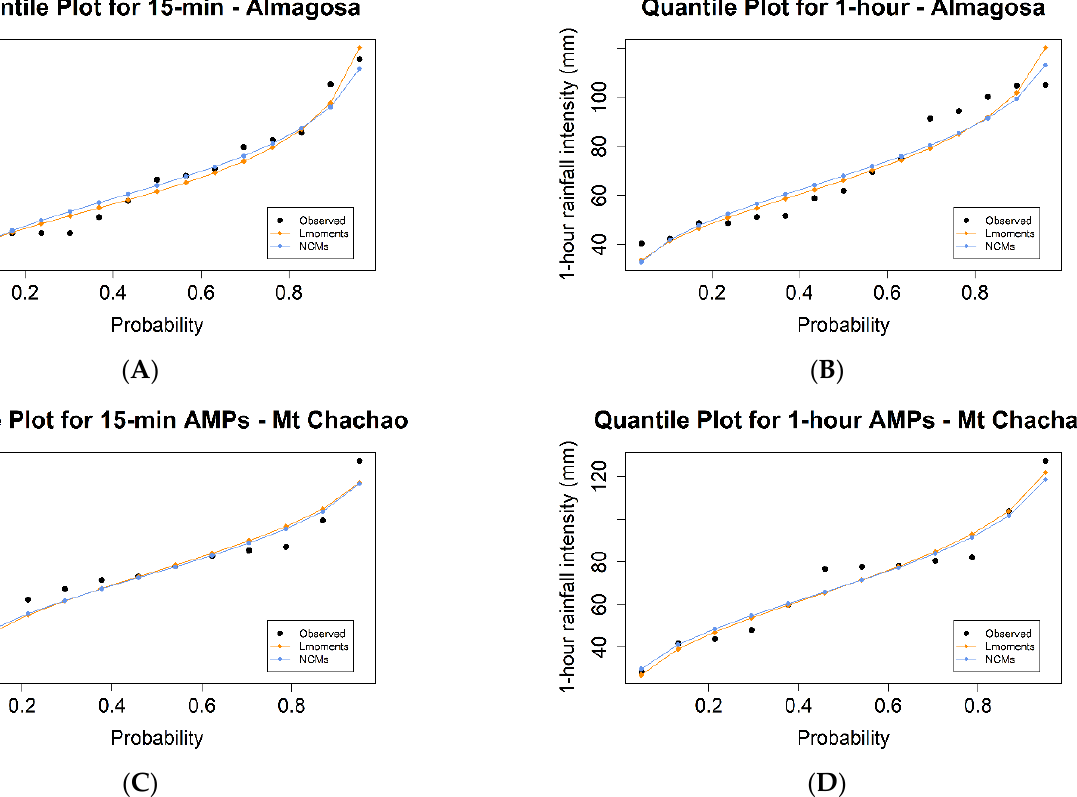
Figure 3. Quantiles estimated by conventional parameter estimation method (L-moments) and the proposed NCMs. ( A , B ) are quantiles plot for 15-min and 1-h durations for Almagosa, and ( C , D ) are those for Mt. Chachao.